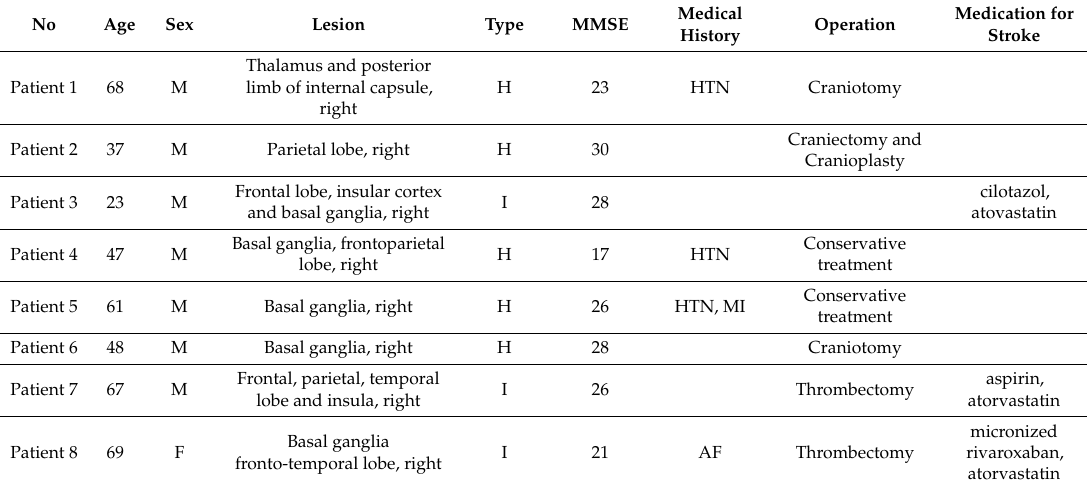
Table 2. Demographic data of eight patients and the results with the Korean Mini-Mental Status Examination